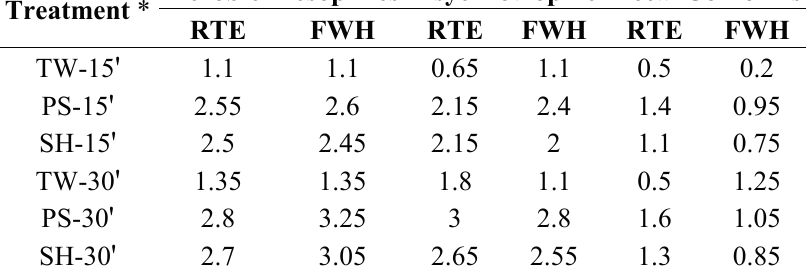
Table 4. Results of the mean reduction (log made to the ready-to-eat (RTE) and fresh whole head (FWH) lettuce submitted to different sanitization